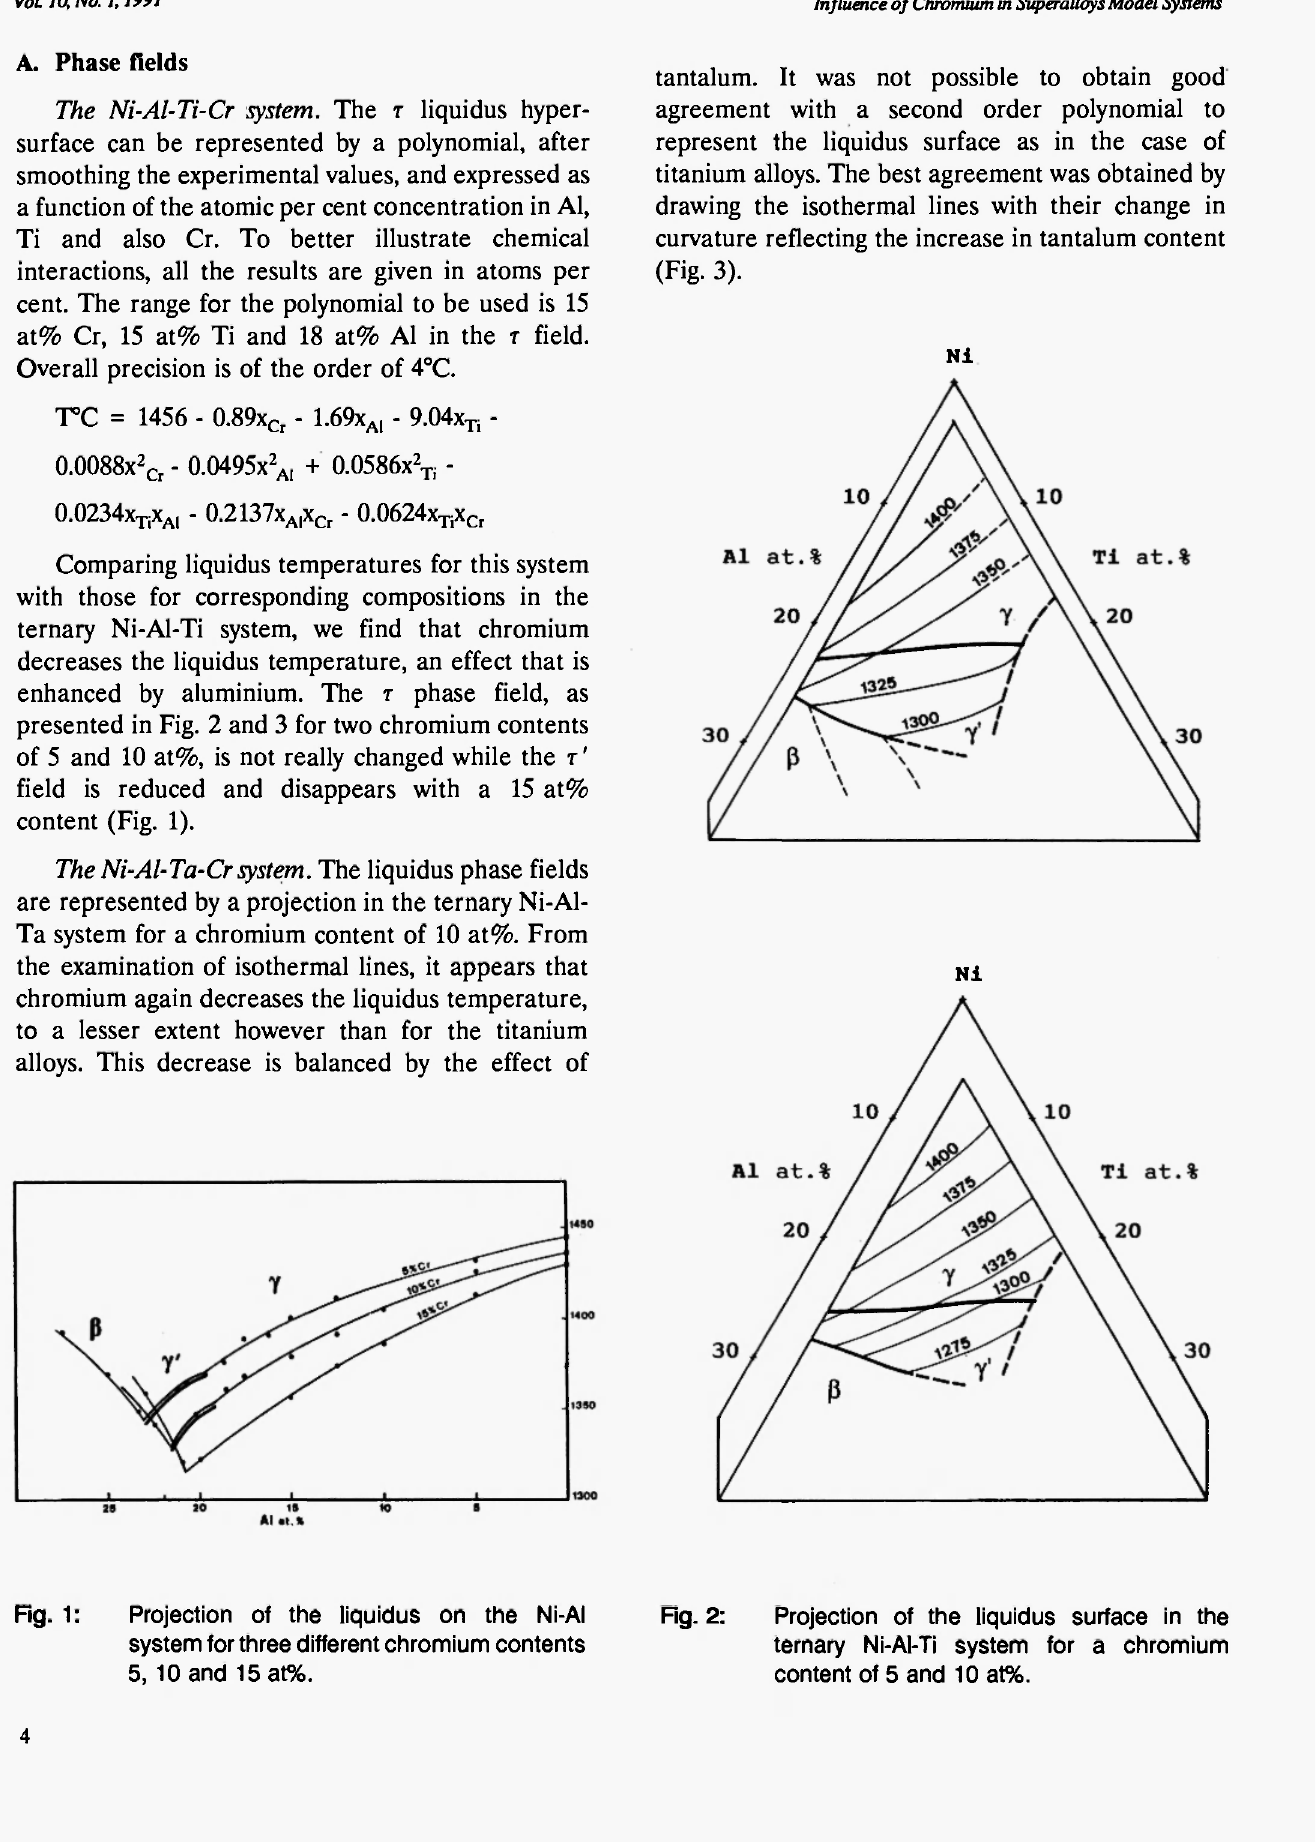
Fig. 2: Projection of the liquidus surface in the ternary Ni-Al-Ti system for a chromium content of 5 and 10